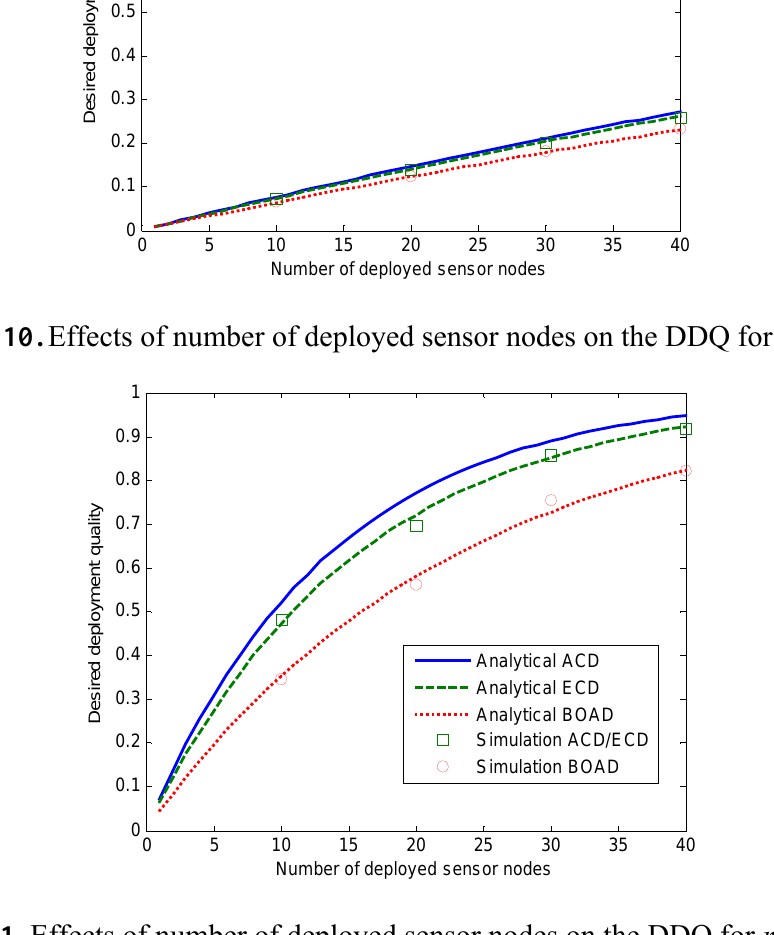
Figure 11. Effects of number of deployed sensor nodes on the DDQ for r = 30